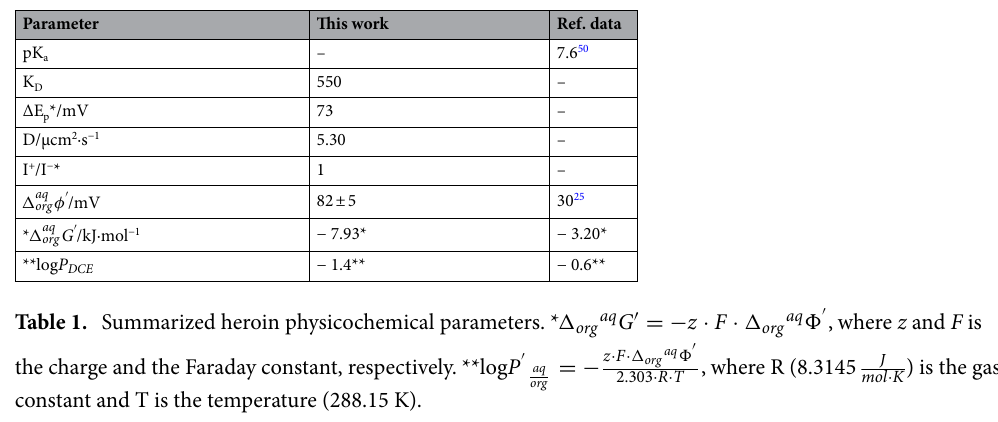
Parameter This work Ref. data – 7.6